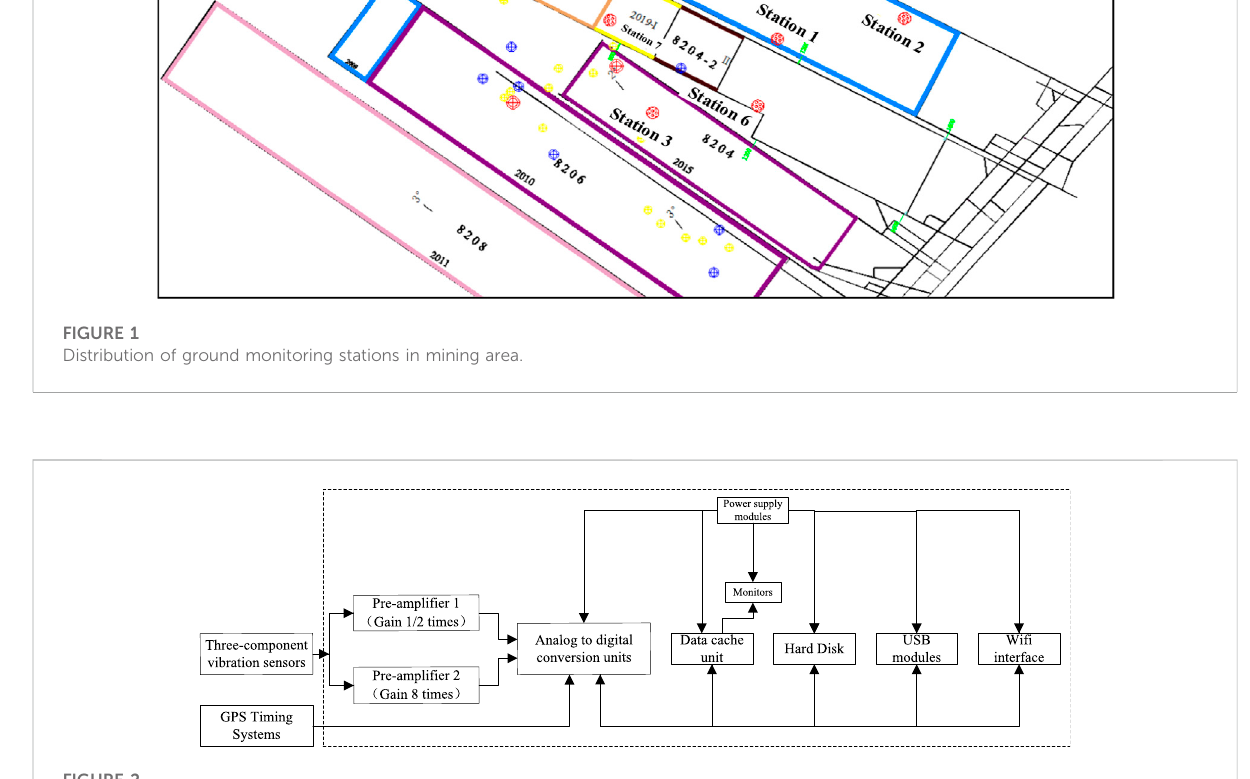
FIGURE 2 Structure of the high frequency microseismic